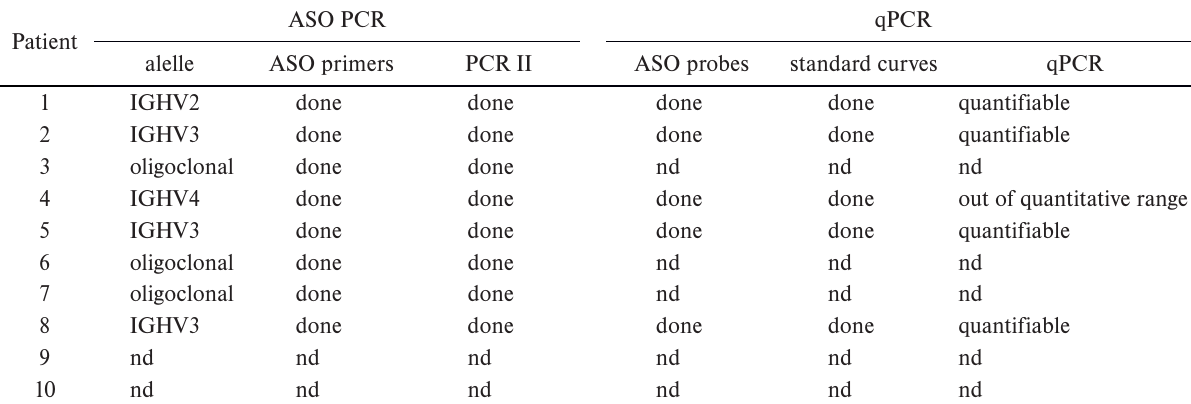
Table 3. A summary of individual steps of PCR detection of tumor-specific marker in MM (nd – not done).